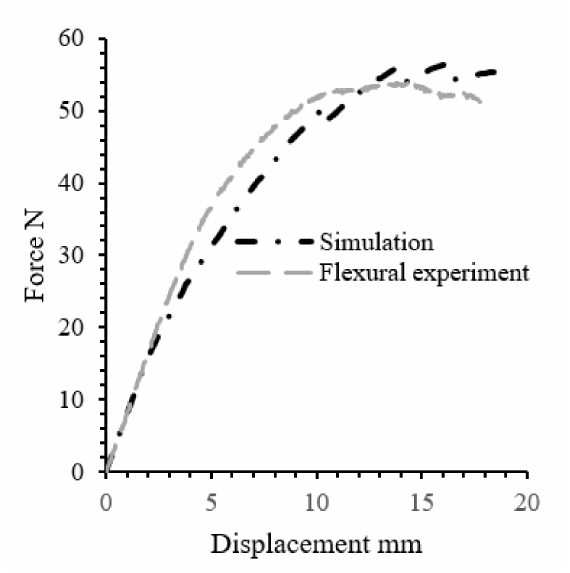
Figure 5. Force-displacement simulation of a three-point bending